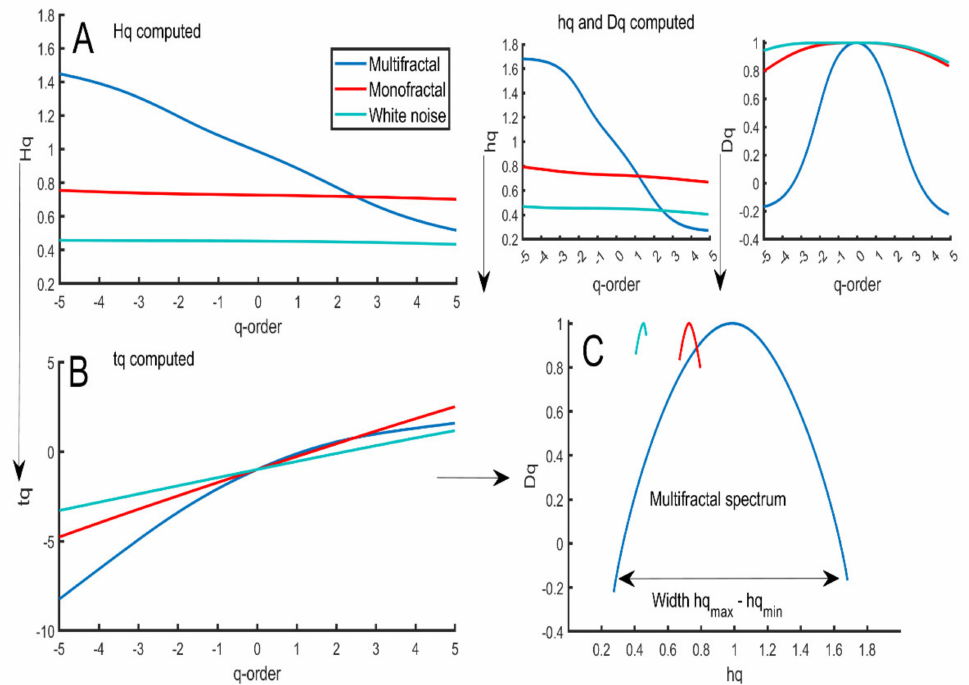
Figure 4. Multifractal spectrum of multiple representations for white noise (green), multifractal (blue), and monofractal (red). Computed Hurst exponent ( A ), mass exponent ( B ), multifractal spectrum ( C